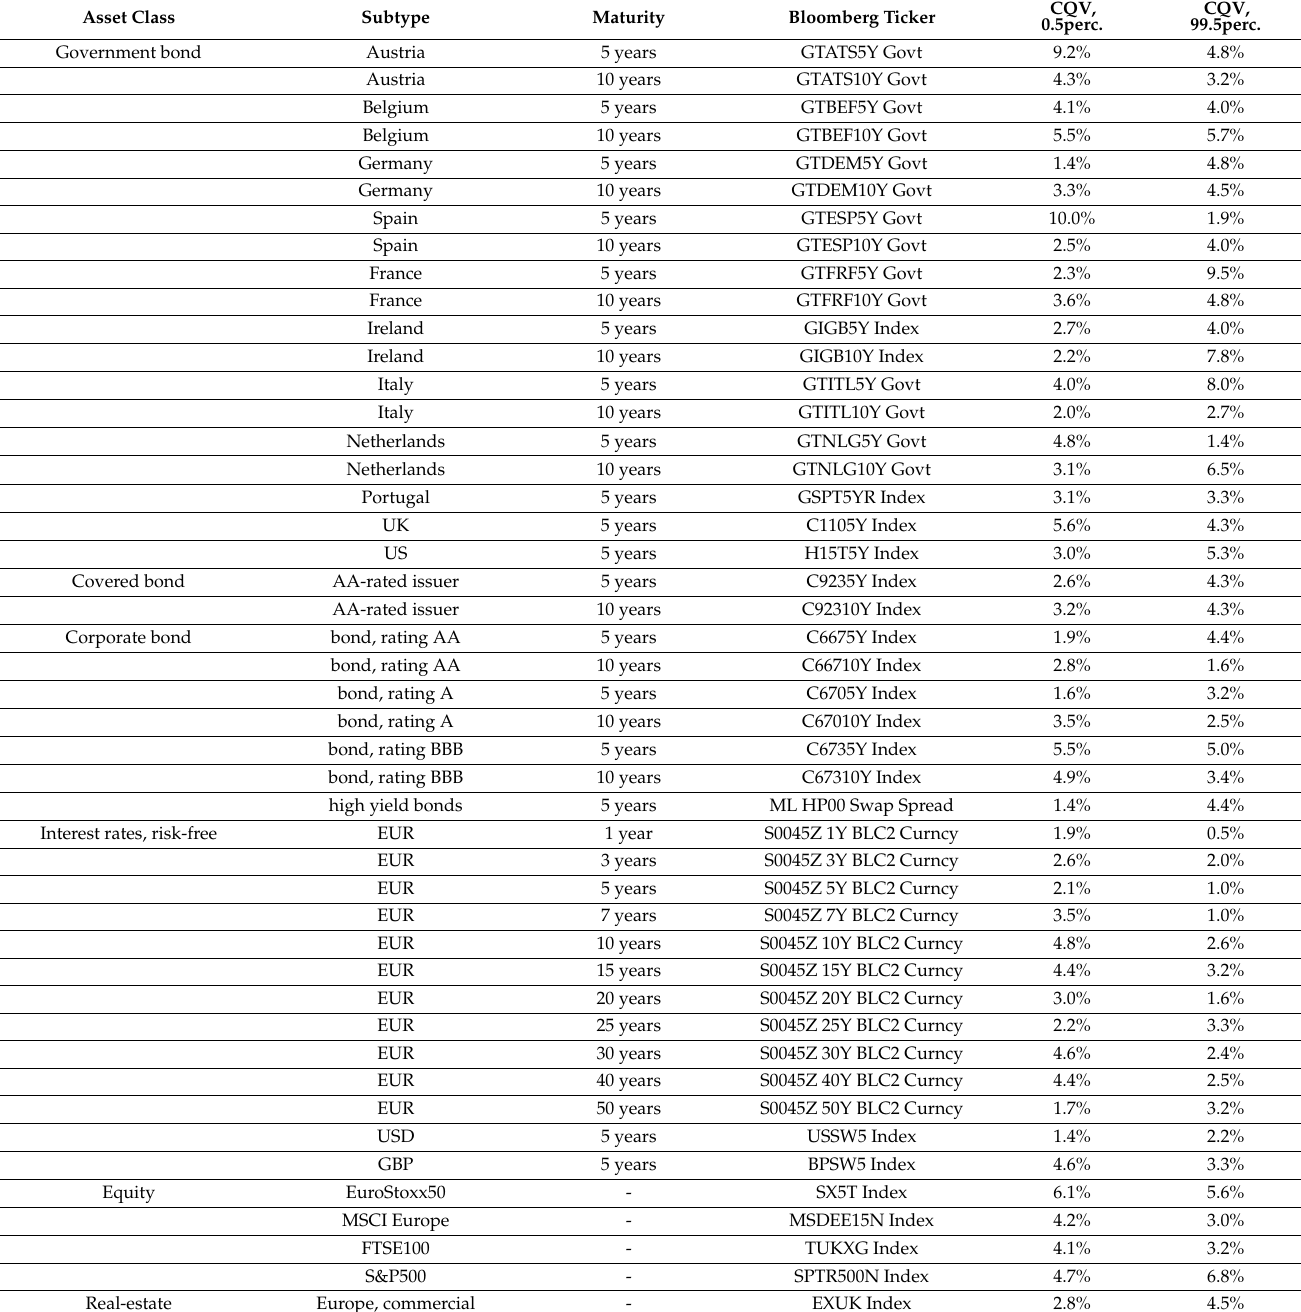
Table A1. Risk factors, Bloomberg data source and CQV used in the GAN-based internal